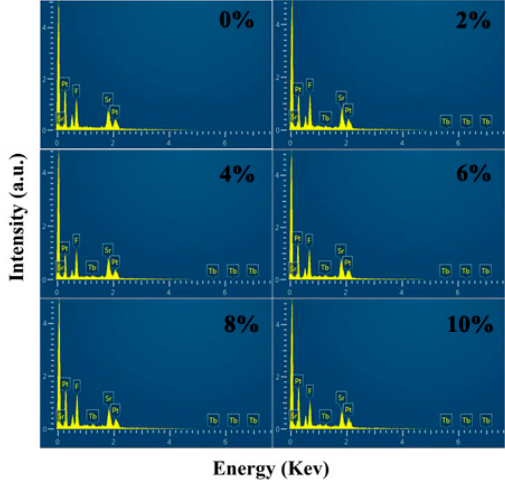
Figure 2. The EDS spectra of SrF 2 nanoparticles with different Tb doping concentrations.